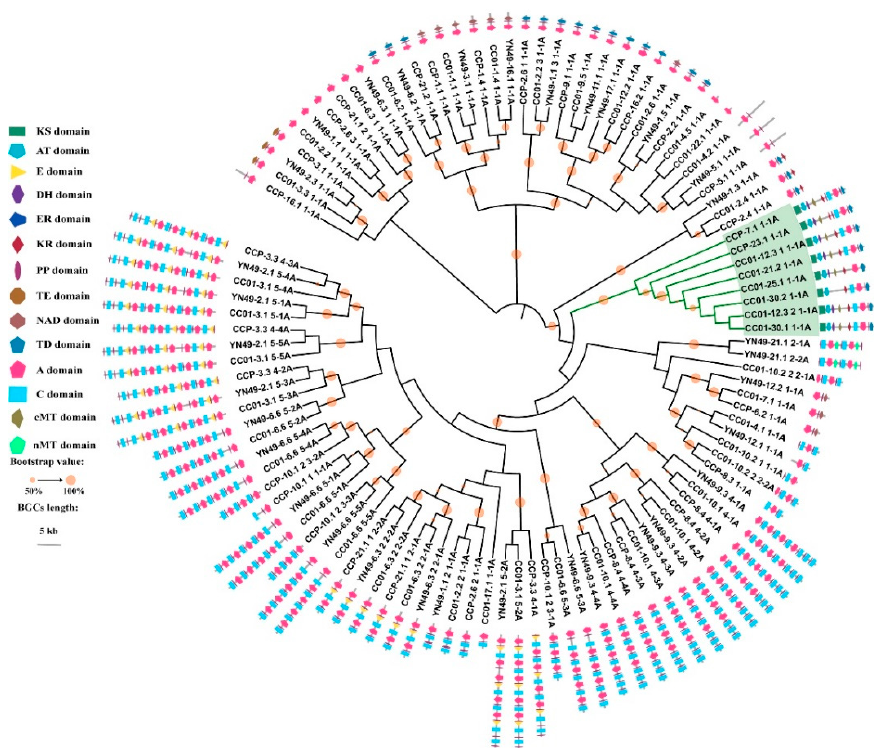
Figure 8. Phylogenetic and structural domain analysis of NRPSs and PKS/NRPSs from C. cassiicola YN49, CC01 and CCP based on A domain sequences. NRPSs and PKS/NRPSs domains were determined based on antiSMASH analysis. The ML tree was generated using MEGA 6 with the WAG model. Bootstrap support greater than 50% is shown on the branches. A domain sequences used in this analysis are listed in Supplementary Materials File S6.